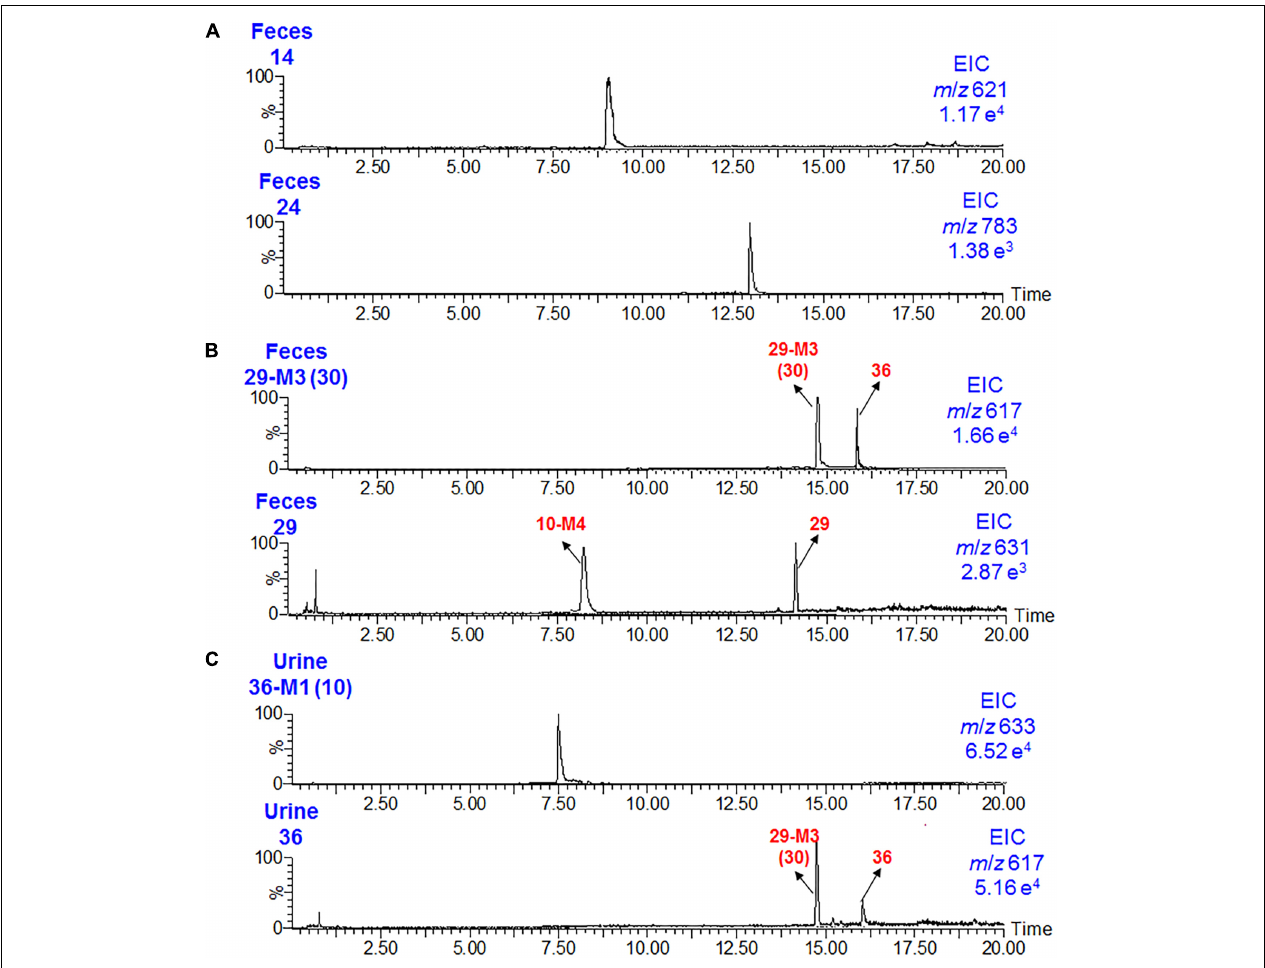
FIGURE 5 | Ion chromatograms of 14 and 24 (A) , 29-M3 ( 30 ), and 29 (B) in rat fecal samples, and of 36-M1 ( 10 ) and 36 (C) in rat urine samples after the oral administration of the